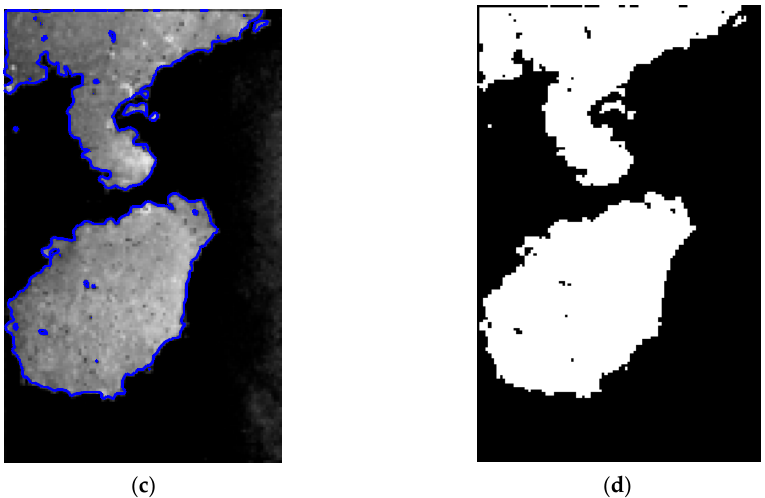
Figure 10. Extraction results of global image as initial contour: ( a ) Global initial contour of target image; ( b ) The position of global initial contour in target image; ( c ) Shoreline extraction result; ( d ) Binary map of the extraction results of shoreline. Table 3. Comparison of different initial contour extraction results.